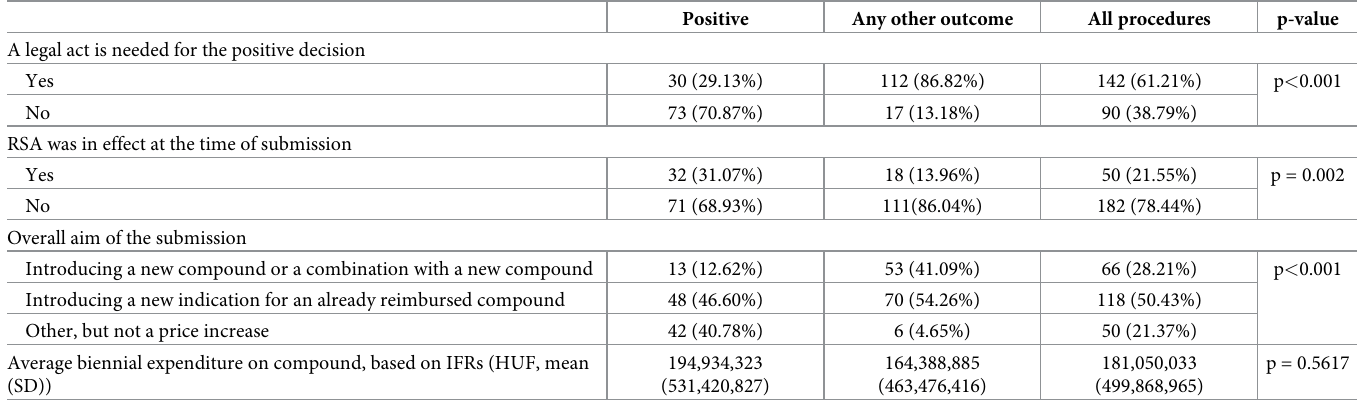
Table 1. Description of the submissions according to independent variables.